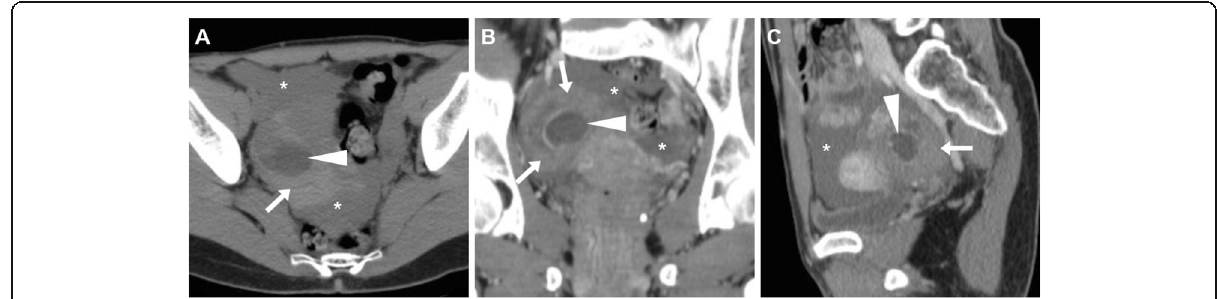
Fig. 12 Haemoperitoneum shown at CT ( a – c ) as pelvic effusion (asterisk) with attenuation higher than that of water, caused by ruptured corpus luteum seen as a 3-cm right adnexal cystic lesion (arrowheads) with enhancing wall, surrounded by high-attenuation ‘ sentinel clot ’